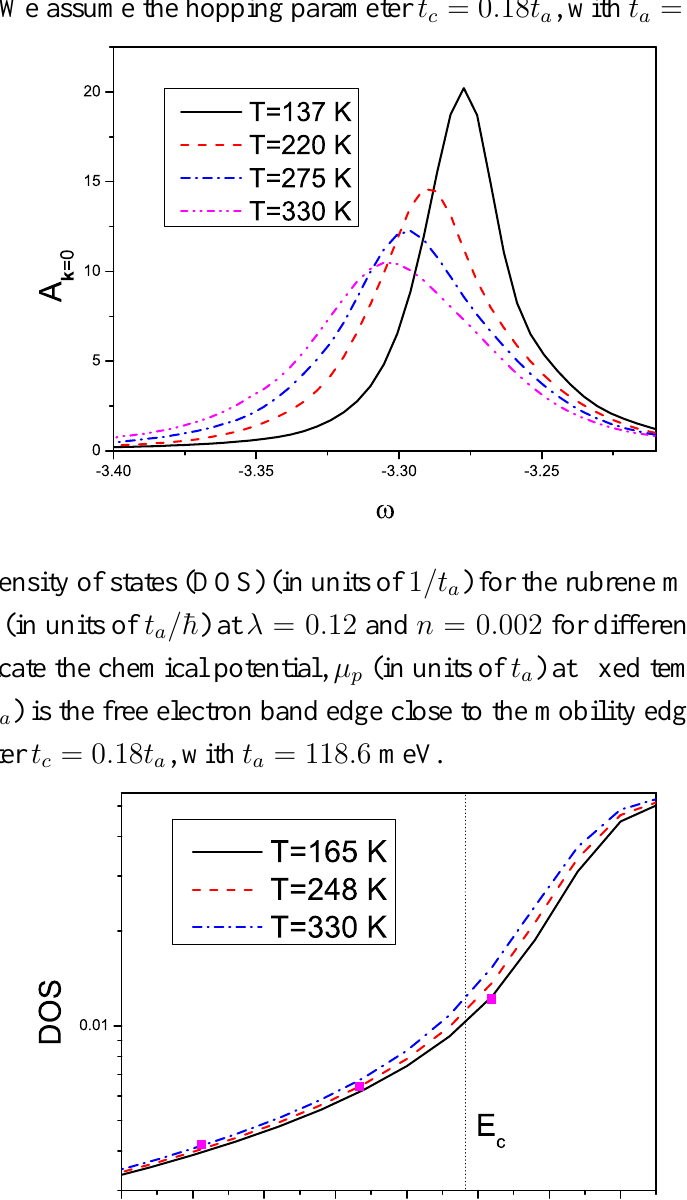
Figure 3. The spectral function (in units of 1 /t as a function of the frequency (in units of t temperatures, T. We assume the hopping parameter t